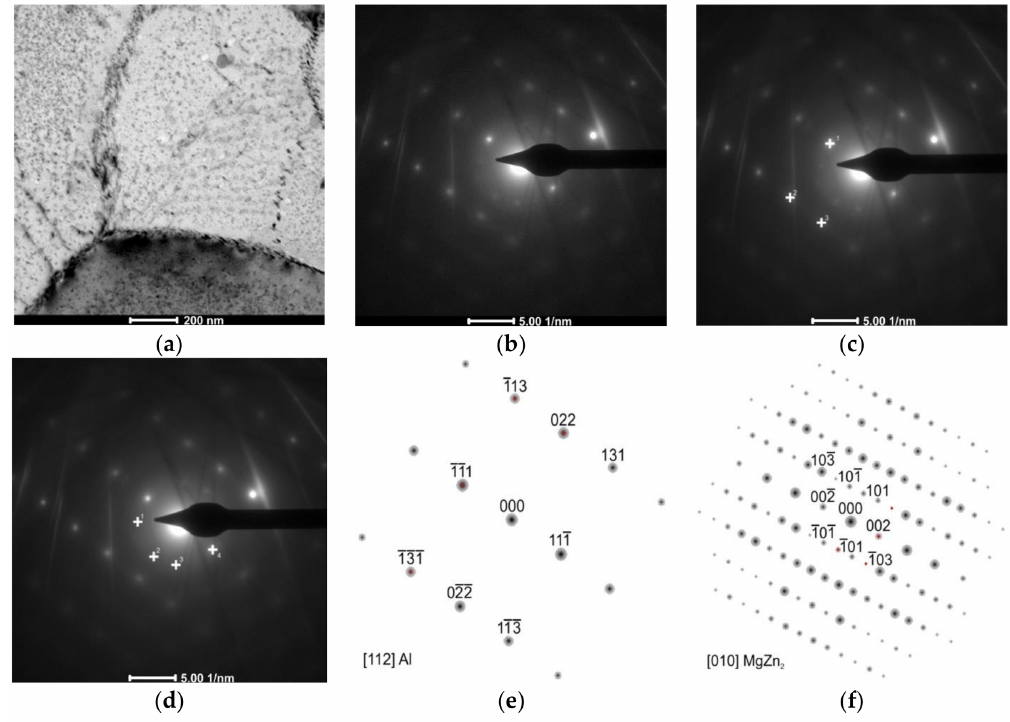
Figure 5. The AlZn6Mg0.8Zr alloy after CHT: ( a ) substructure of investigated alloy with stochastic distribution of precipitations inside subgrains and along their boundaries; ( b ) electron diffraction; ( c ) marked reflections of α solution matrix; ( d ) marked reflections of MgZn 2 particle; ( e ) solution of α phase matrix diffraction and ( f ) solution of MgZn 2 phase